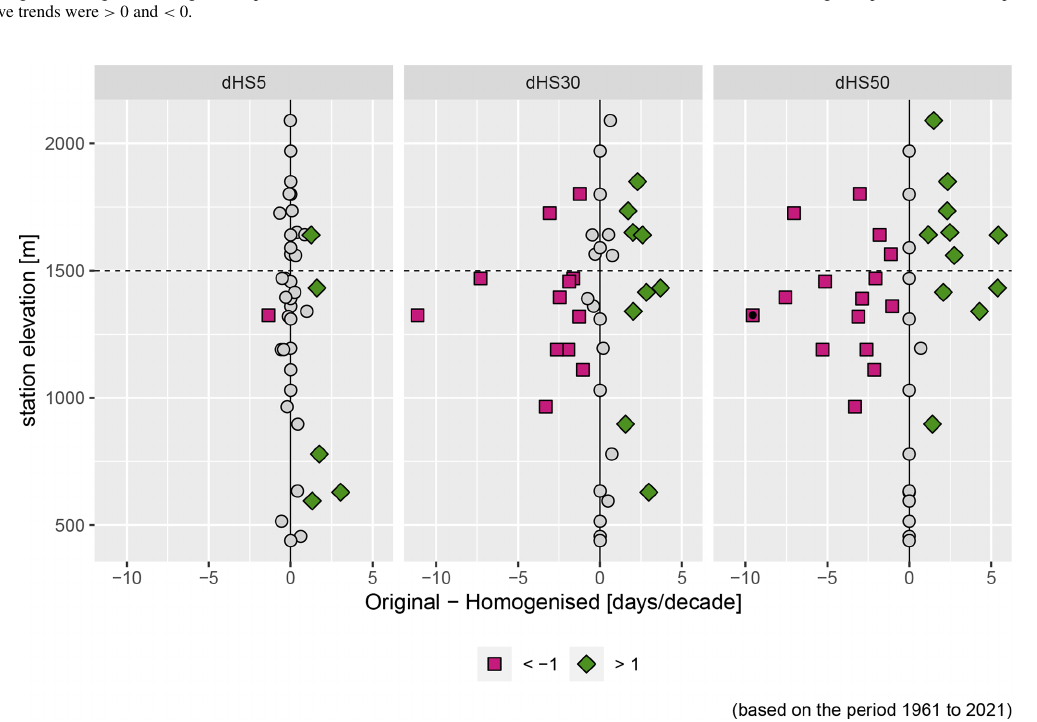
Figure 2. Difference in snow day trends between original and interpQM adjusted series for thresholds 5, 30 and 50cm (dHS5, dHS30 and dHS50). Purple squares indicate stations with a result of < − 1, green diamonds > 1d/decade. Black dots indicate a significant difference. Positive values indicate a lower positive or a more strongly negative trend after